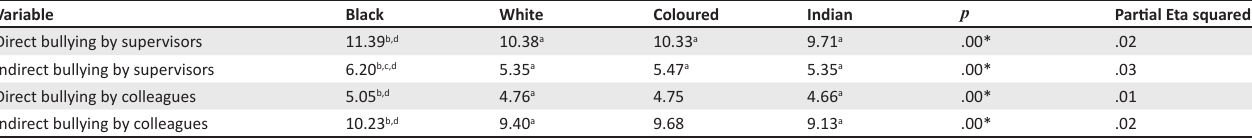
TABLE 5: Analysis of variance – differences in workplace bullying dimensions based on race. Variable